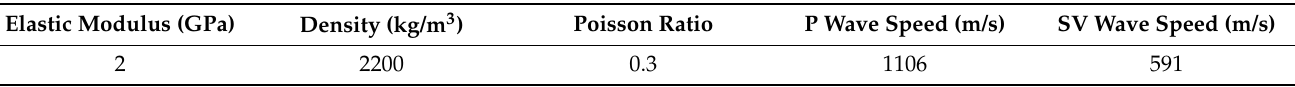
Figure 2. The 3D finite element model (point A is at the center of the top surface of the structure). Table 1. Parameters of the validation model.